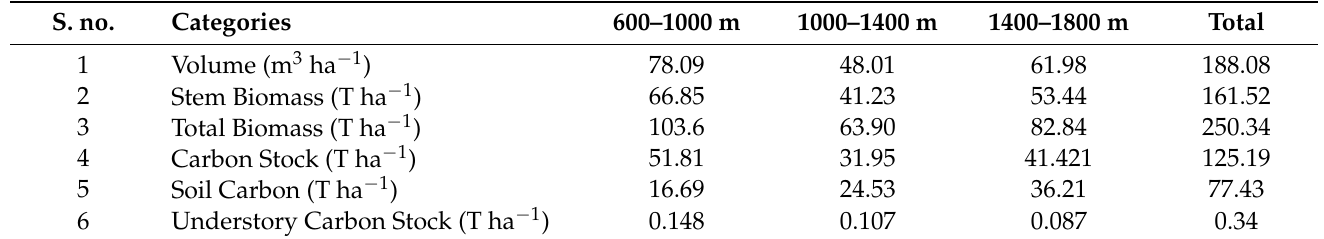
Table 4. Total volume, stem biomass, tree biomass and carbon stock (T ha − 1 ) of woody tree species, under story vegetation and soil 74 of Monotheca dominated forests across different elevation ranges in